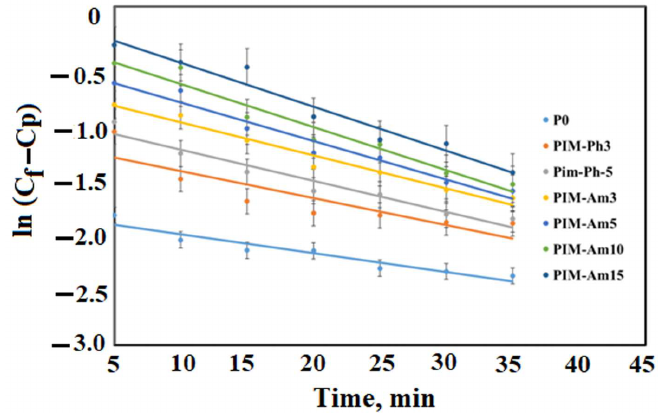
Figure 7. Kinetics of Cd removal through filtration onto the membranes studied. Table 2. The rate constant of cadmium removal for the studied membranes. Membrane Code Membrane